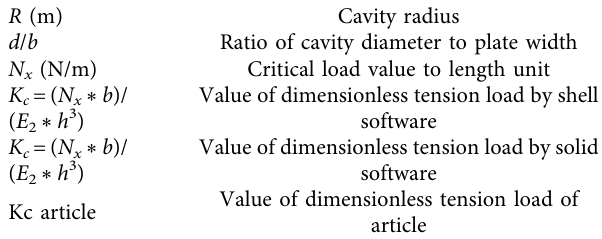
Table 8: Introduction of used parameters in the modeling.